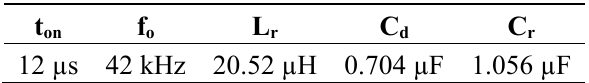
Table 3. Parameters of buck-resonant